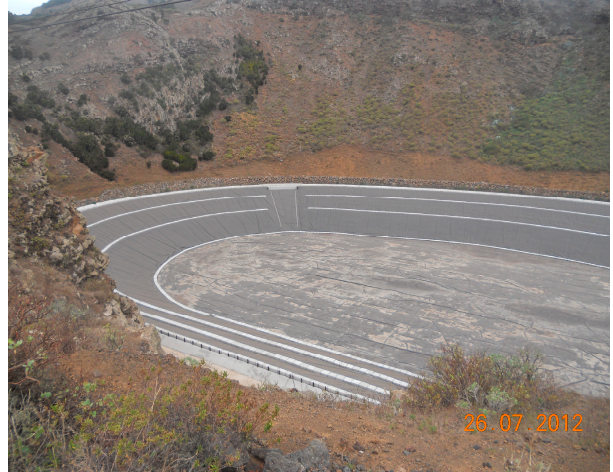
Figure 9. The upper reservoir of the hydropower plant. Photo: G. Jastrz ę bska.